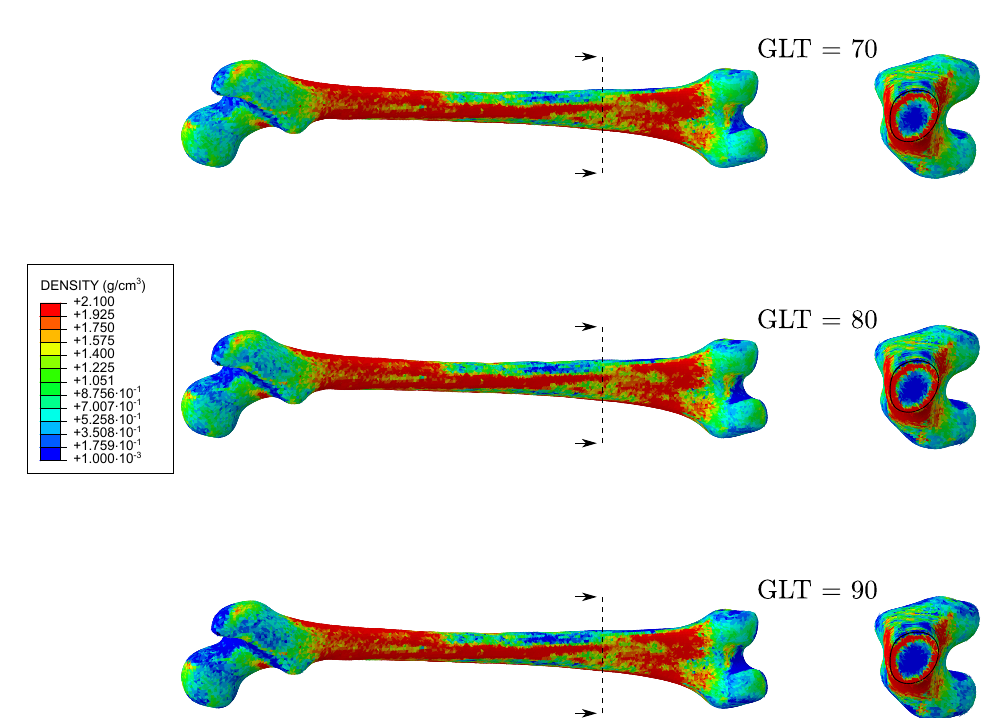
Figure 2. Distribution of bone density estimated from Equation (3) for three GLT: in the whole femur ( left ), in a diaphyseal cross-section ( right